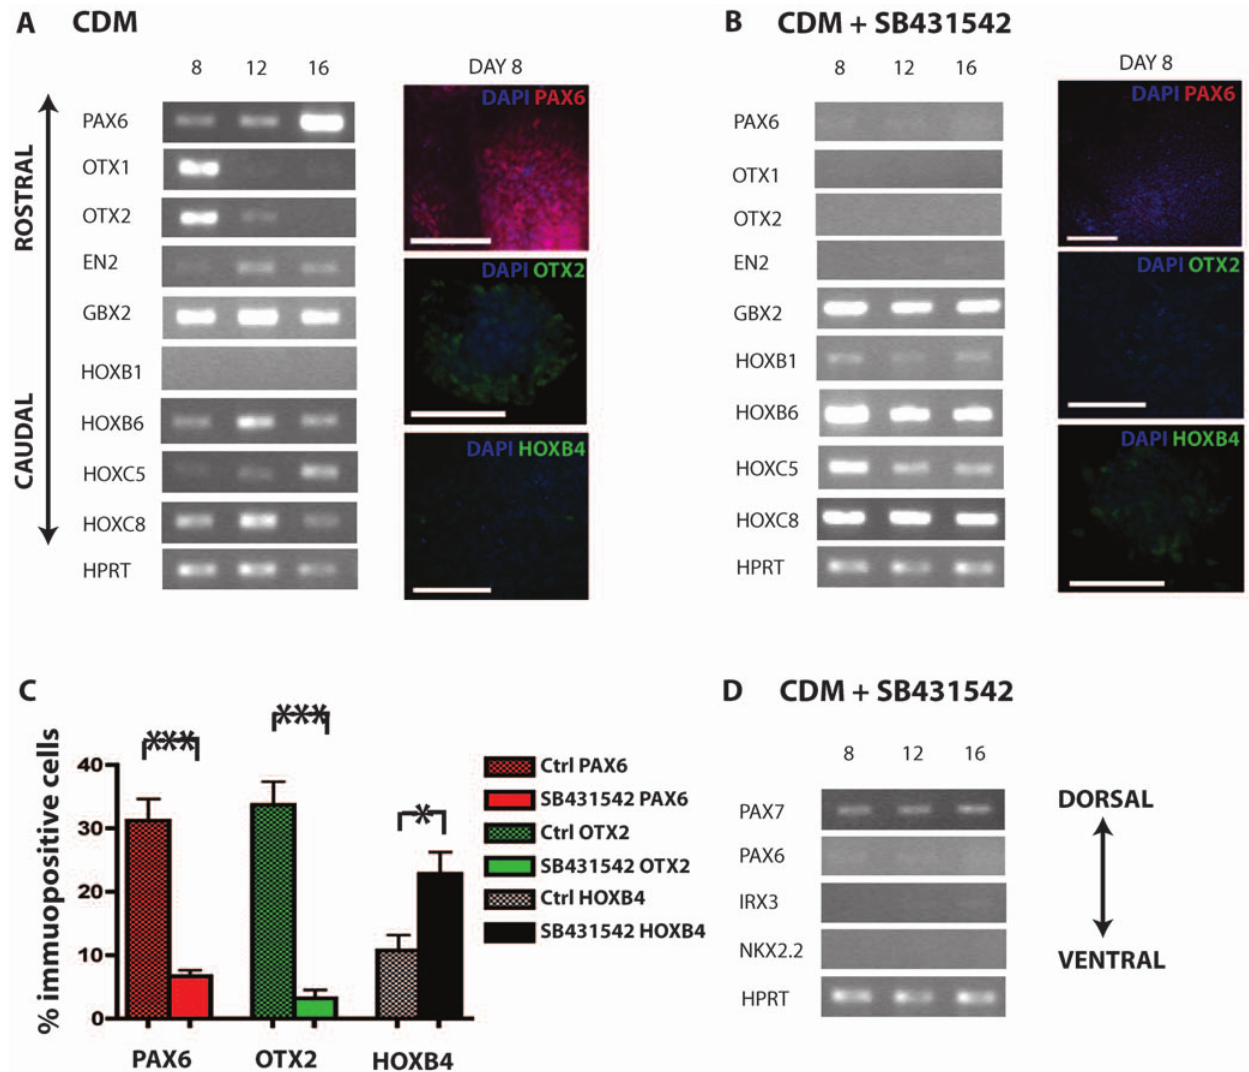
Figure 2. Activin/nodal inhibition using the small compound SB431542 imposes a posterior positional identity on derived neural progenitors. Under control conditions, transcriptional profiling reveals expression of a range of rostro-caudal markers, indicating an heterogeneous positional identityofneural precursors(A).Immunohistochemistry confirms thepresence ofanteriormarkersPAX6and OTX2(A).Treatmentwith SB431542 causes a significantdownregulationof anteriorpositionalmarkers including PAX6, OTX1,OTX2 and themidbrain marker EN2 bytranscriptional analysis and significantly reduced expression of PAX6 and OTX2 by immunohistochemistry compared to control conditions (B&C). Posterior markers including GBX2, HOXB6 and HOXC8 in the SB431542 treated group are strongly expressed at the RNA level (B) and quantitative immunohistochemistry of posterior marker HOXB4 (C) reveals significant upregulation with SB431542 treatment. Transcriptional profiling of dorso-ventral markers suggests that a predominantly dorsal identity within the caudal neuraxis is demonstrated by SB431542 generated hESC-NPCs (D). Scale bars all 100 m m * =p , 0.05, *** P , 0.001.